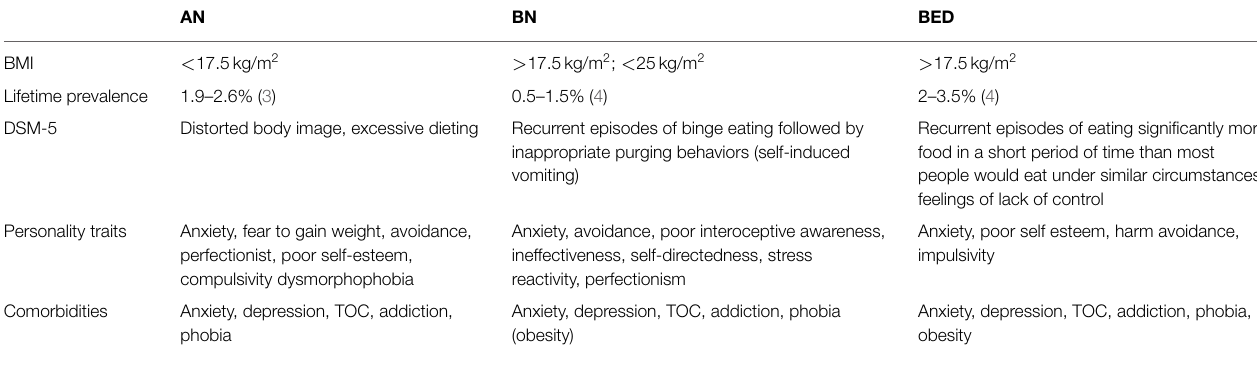
TABLE 1 | Main characteristics of the mean eating disorders: anorexia nervosa (AN), bulimia nervosa (BN), binge eating disorder (BED) . AN